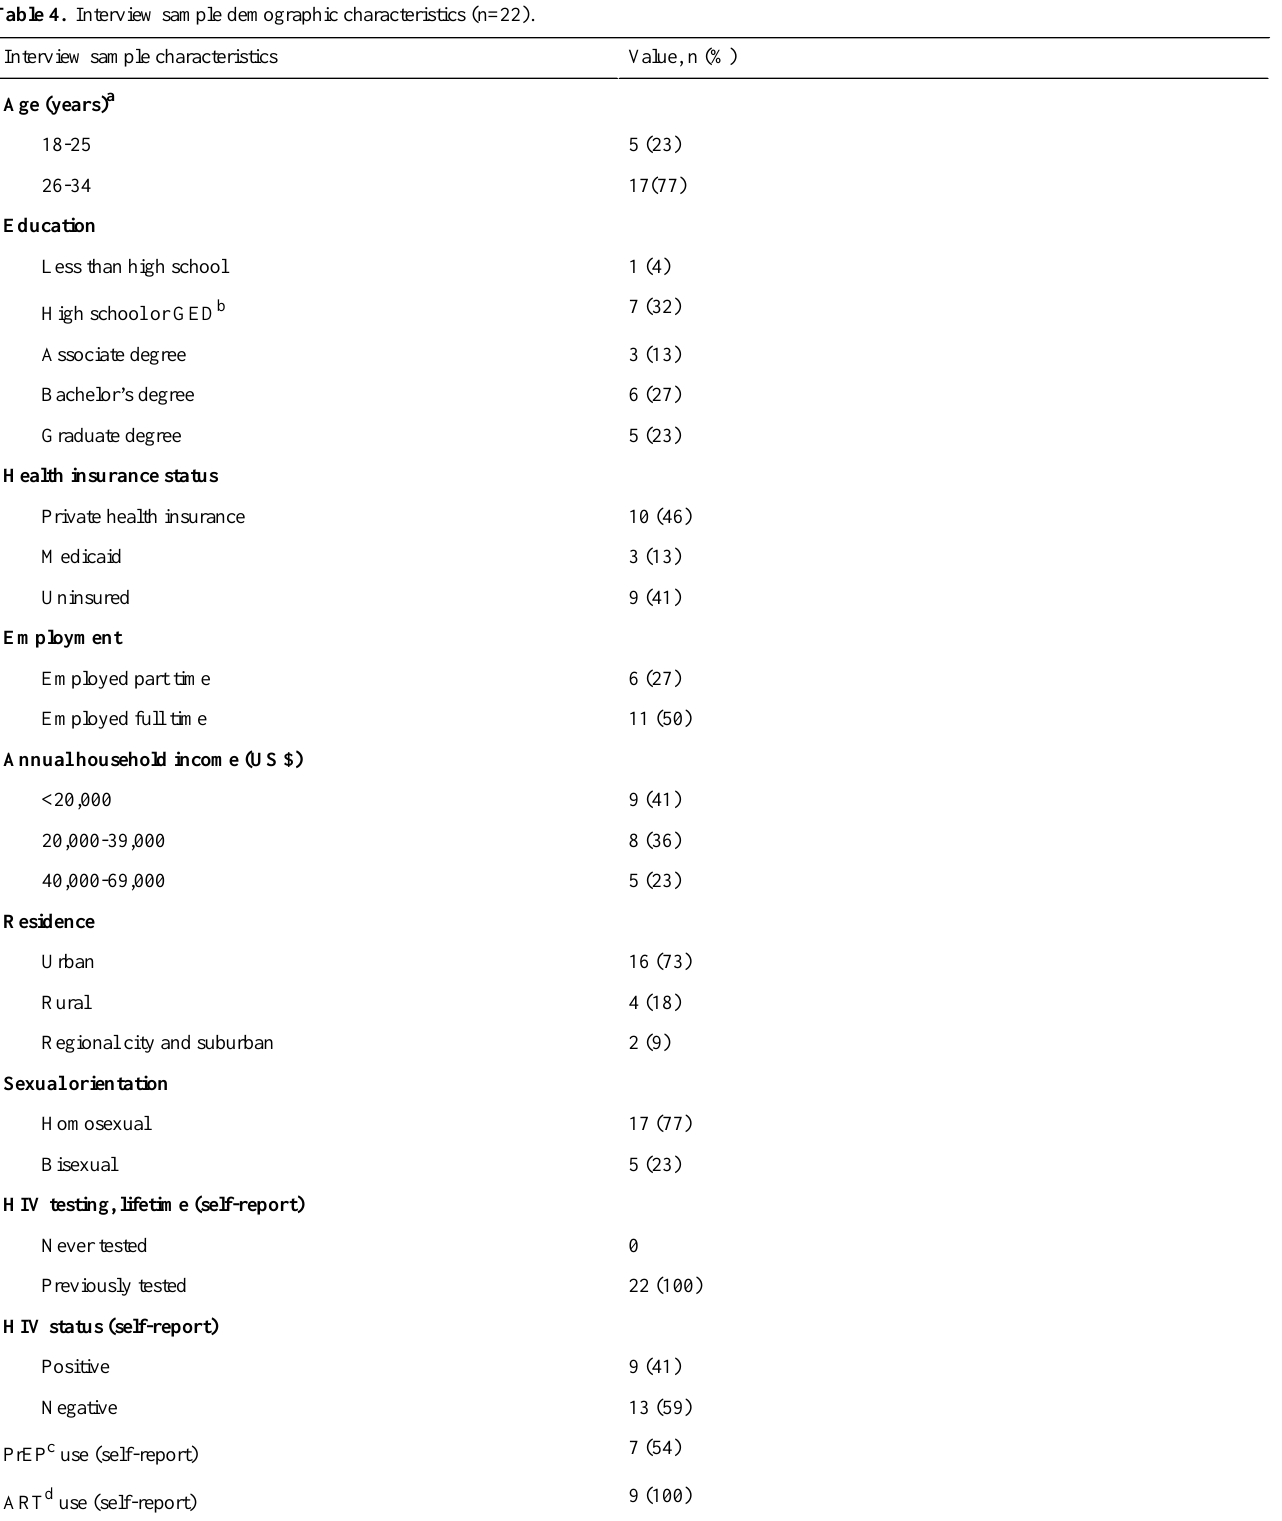
Table 4. Interview sample demographic characteristics